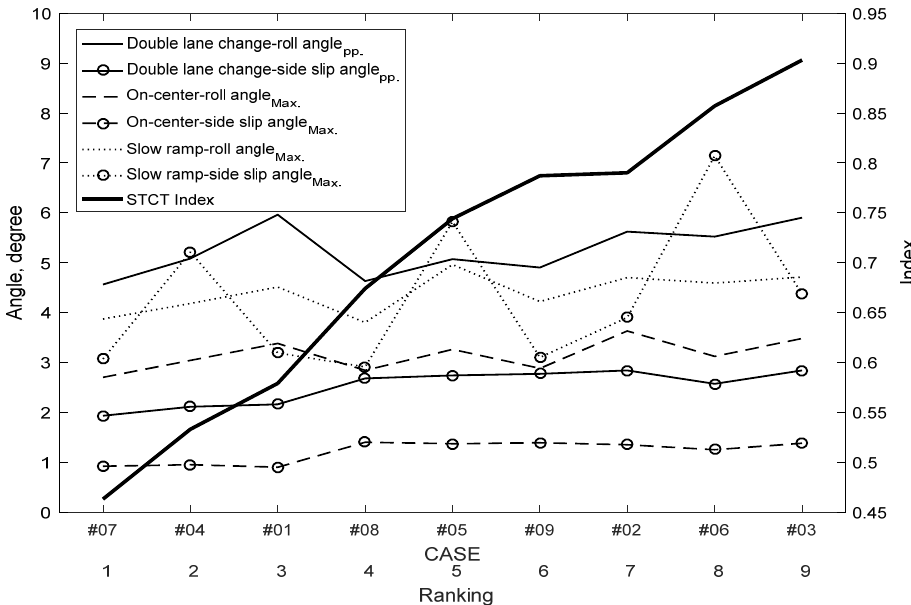
Figure 16. Suspension and tire cornering performance index (STCT)